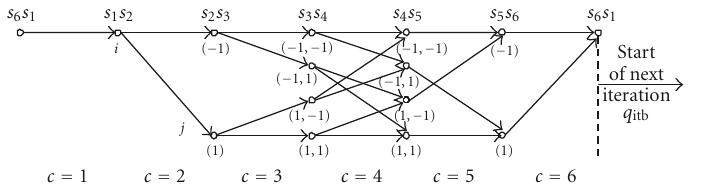
Figure 6: ITB-DDFSE trellis for explicit CCI estimation in symbol estimator #1 in Figure 5(a). The trellis is shown for the UCA example in Figures 3(a) and 3(b) using BPSK